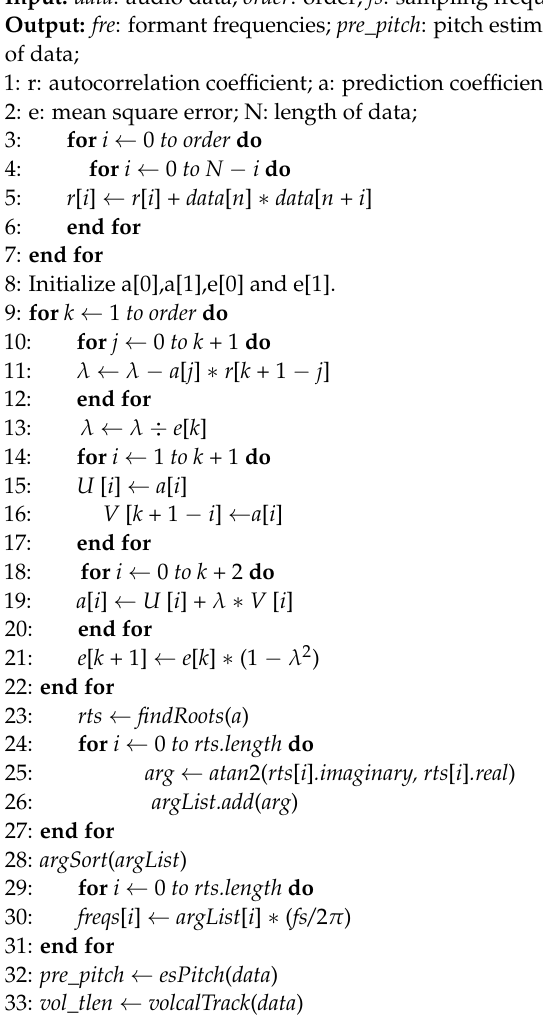
Algorithm 2 Speech Signals Articulation Feature Extraction